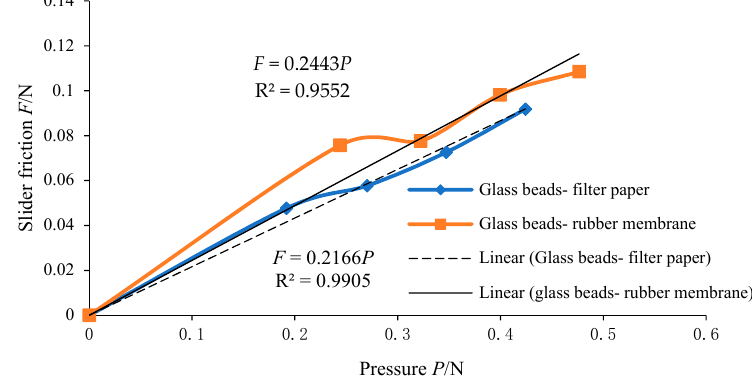
Figure 6. Sliding friction - pressure curve.